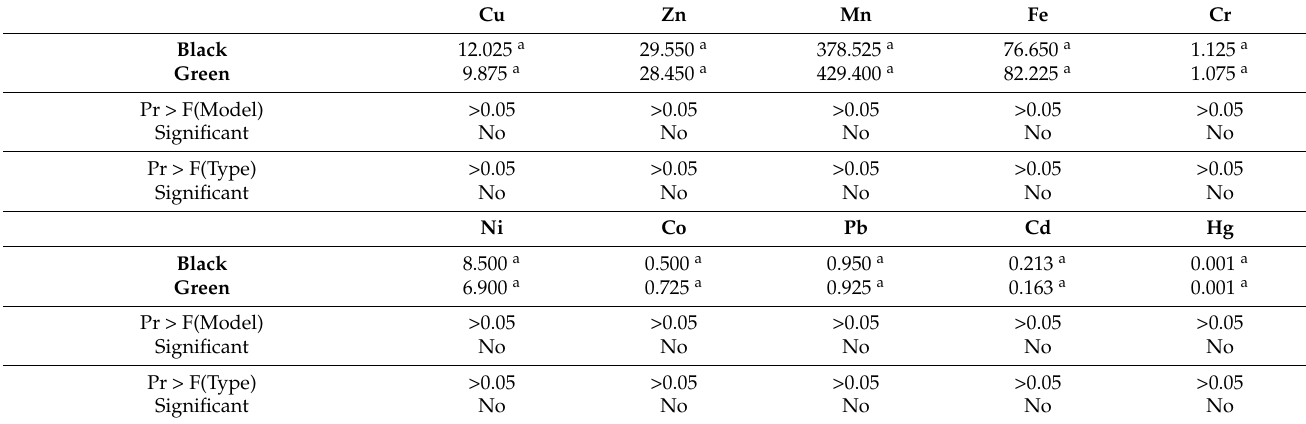
Table 6. ANOVA Duncan and REGWQ comparison of average concentration of heavy metals in tea in terms of their fermentation